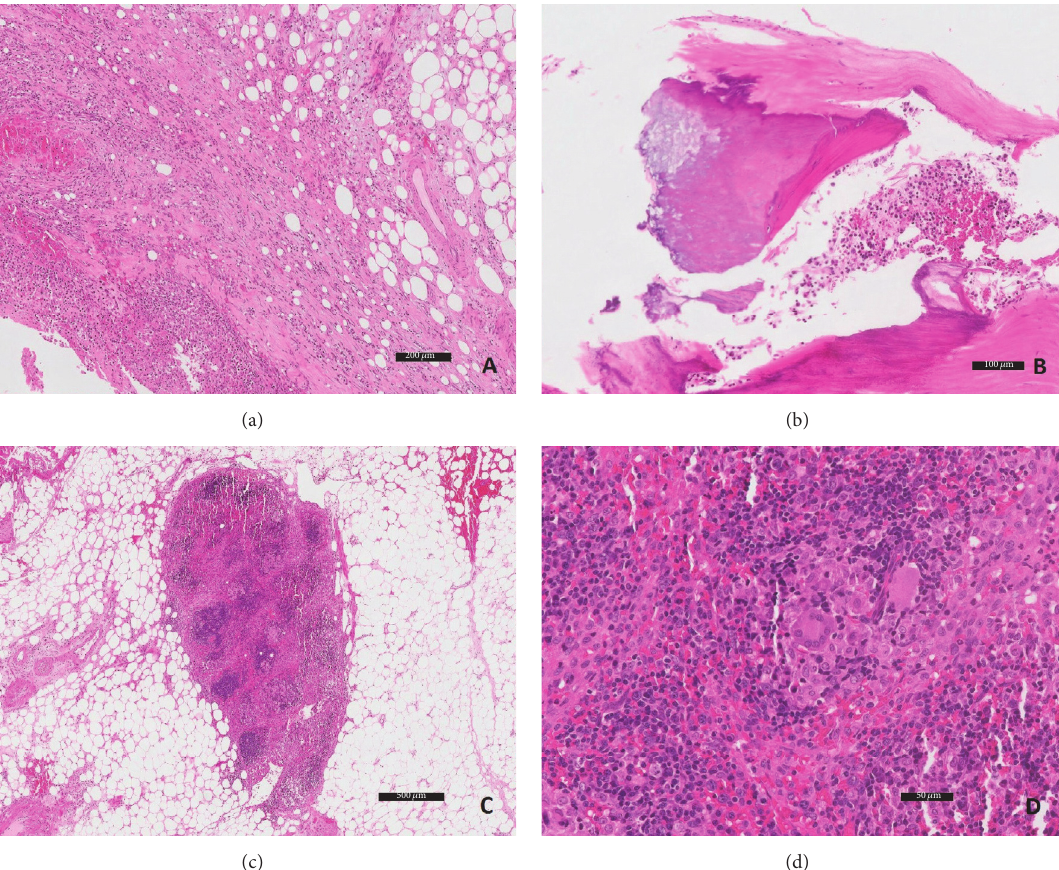
Figure 2: Microscopic (hematoxylin and eosin stain) photos of the resected portion of the aorta. (a) Periaortic adipose tissue with abundant chronic inflammation and fat necrosis. (b) Atherosclerosis and calcifications can be readily identified. (c) Perivascular lymph nodes show granulomatous inflammation. (d) Occasional giant cells are present in the lymph